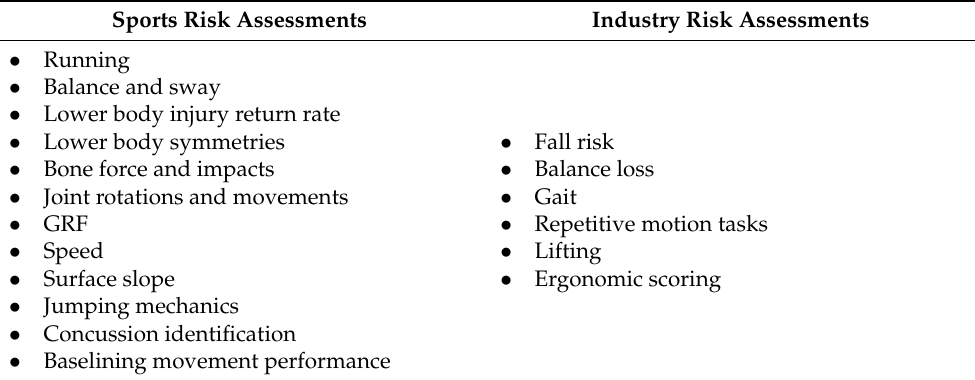
Table 3. Wearable uses for biomechanical risk assessment in sports and industry key